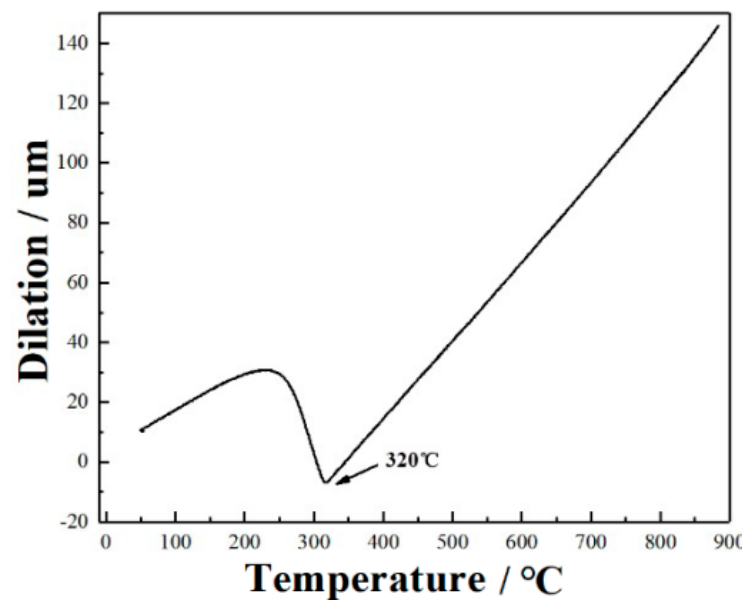
Figure 1. Temperature verses dilation during cooling process.